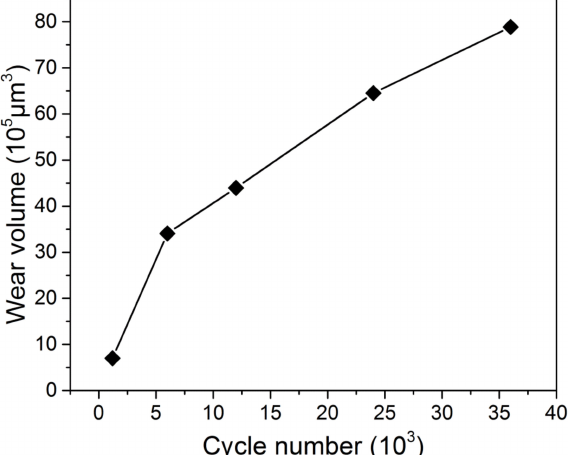
Figure 3. The wear volume of alloy 690TT as a function of cycle